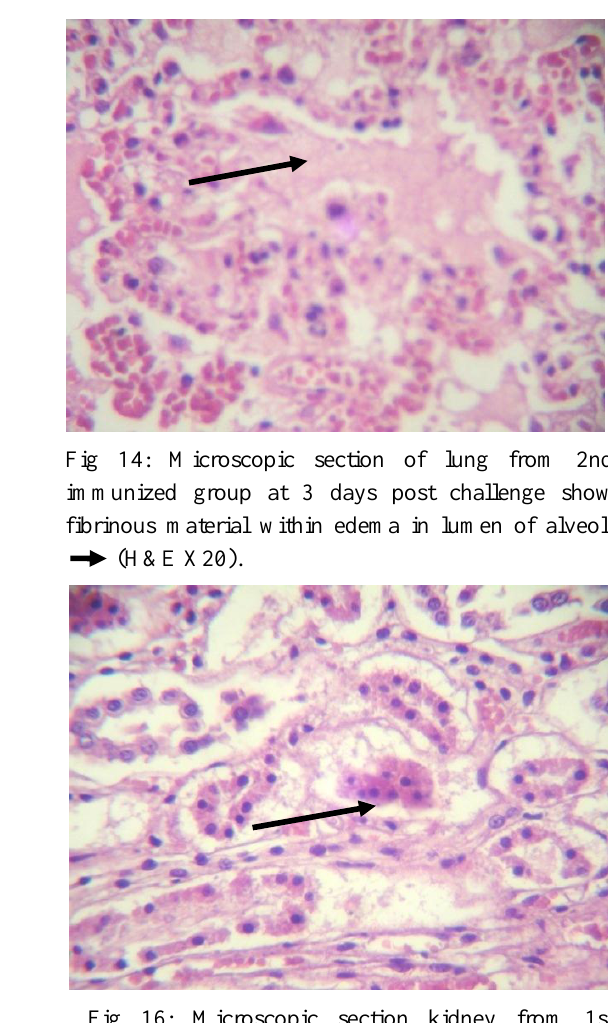
Fig 15: Microscopic section of liver from 2nd immunized group at 3 days post challenge show severe dilation of sinusoids with kupffer cells infiltration mm (H&E X20).